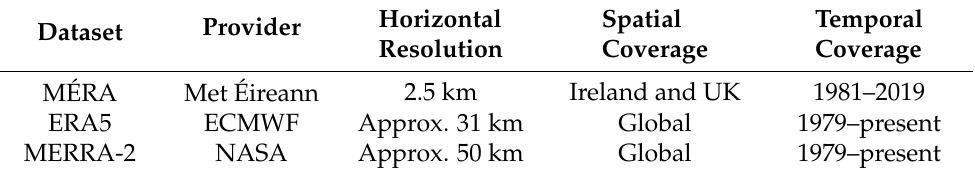
Table 1. Reanalysis